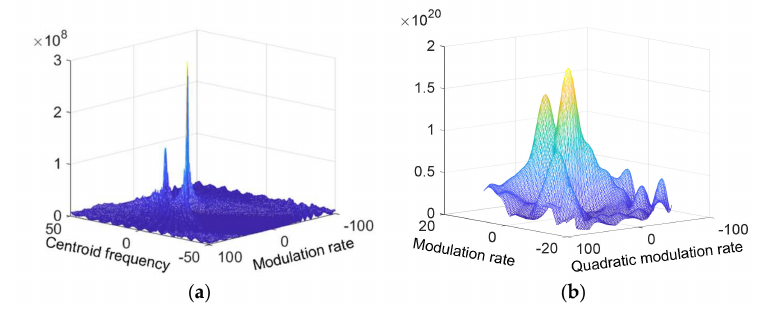
Figure 9. Parameter estimation of the PPS. ( a ) Estimation of linear and quadratic coefficients; ( b ) estimation of quadratic and cubic